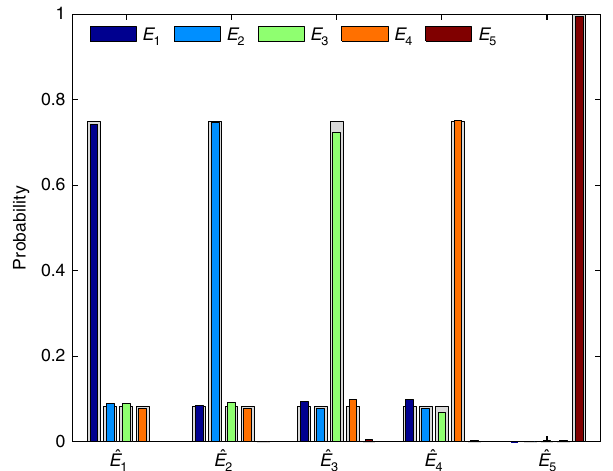
Fig. 3 Experimental veri fi cation of the collective SIC-POVM realized. Here each ^ E i for i = 1, 2, 3, 4, 5 denotes an input state, which corresponds to the POVM element E i of the collective SIC-POVM after normalization. Each input state is prepared and measured 100,000 times. The frequencies of obtaining the fi ve outcomes are plotted using different colors; here the error bars are too small to be visible. For comparison, the probabilities in the ideal scenario are plotted in gray shadow